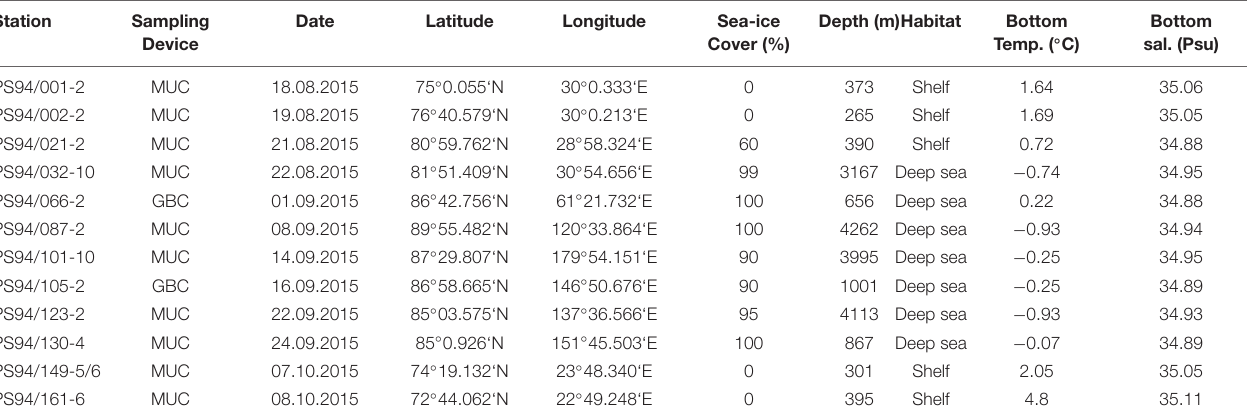
TABLE 1 | List of stations and metadata of